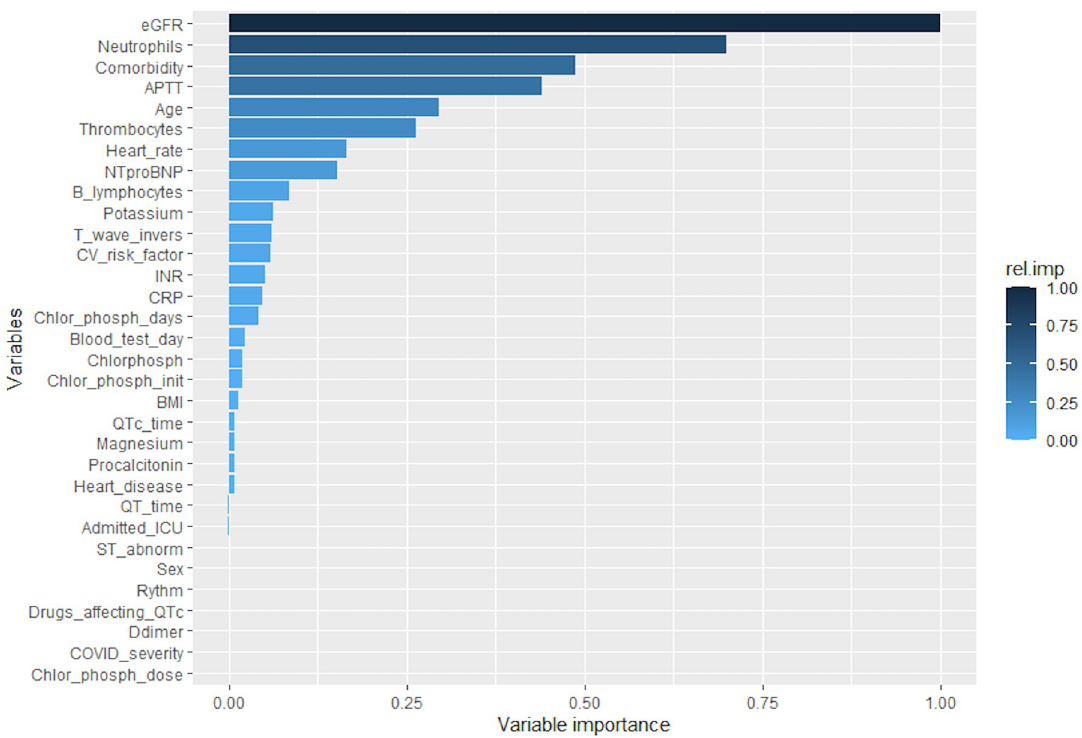
Fig 1. Relative importance of predictors of cardiovascular involvement. eGFR = estimated glomerular filtration rate, comorbidity = numbers of comorbidities, APTT = activated partial thromboplastin time, INR = international normalized ratio, T_wave_invers = T-wave inversion, Chlor_phosph_days = number of days with chloroquine phosphate, CV_risk_factor = cardiovascular risk factors (hypertension, diabetes, dyslipidemia), Chlor_phosph_init = days since symptom onset when chloroquine phosphate was initiated, Blood_test_day = day since symptom onset when blood samples were collected, BMI = body mass index, Chlorphosph = treatment with chloroquine phosphate, Heart_disease = type of previous heart disease specified (cardiac arrhythmia 7, valvular heart disease 2, ischemic heart disease 6, congestive heart failure 1), Chlor_phosph_dose = total dose of chloroquine phosphate. Missing data: eGFR 1, APTT 21, thrombocytes 6, heart rate 19, INR 21, potassium 1, T wave inversion 19, CRP 2, BMI 18, magnesium 34, procalcitonin 34, QTc time 19, QT time 19, d-dimer 33, ST abnormalities 19, rhythm 19. Relative variable importance was calculated using a generalized boosted regression